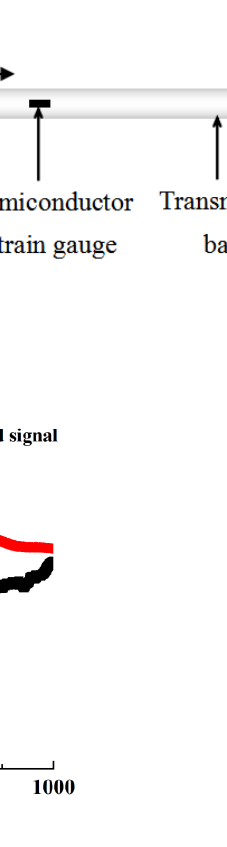
Figure 3. Dynamic original waveform of cement clay.